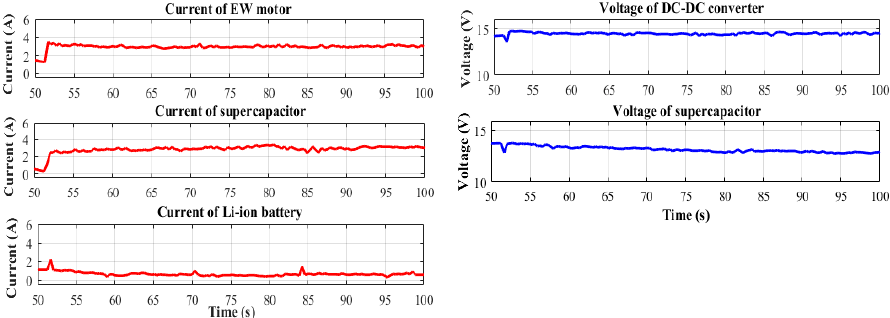
Figure 12. Experimental results for track-ABCD (points B–C).